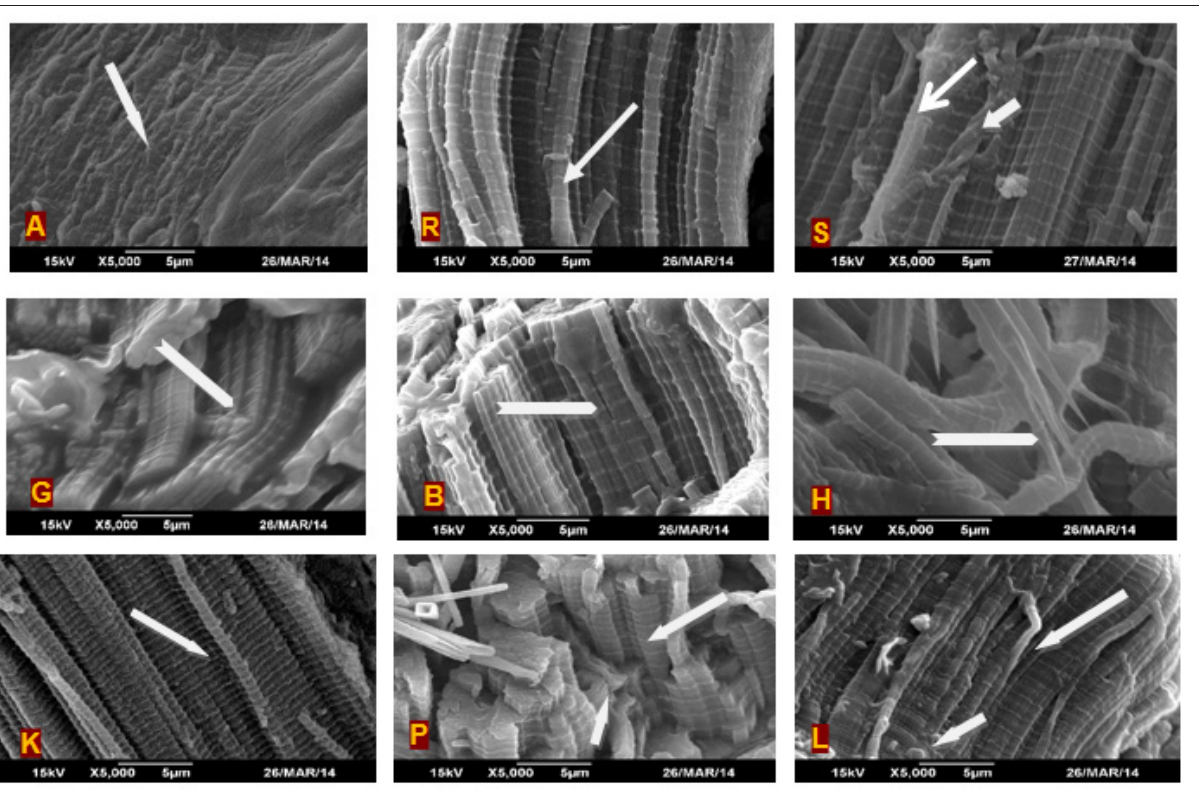
Figure 1: Nanostructure of the Muscularis longissimus thoracis et lumborum muscle of different cattle genotypes and classes: (A) bulls, (R) cows and (S) heifers of non-descript cattle; (G) bulls, (B) cows and (H) heifers of Bonsmara cattle; and (K) bulls, (P) cows and (L) heifers of Nguni